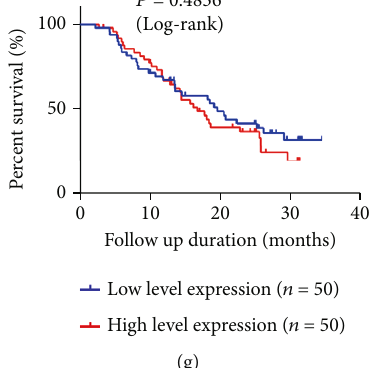
Figure 1: SIX1 expression in PC. (a, b) IHC scores for SIX1 expression in 100 pairs of PC tissues and adjacent tissues. (c) Representative IHC images of SIX1 expression in PC tissues and adjacent tissues. (d) According to IHC, SIX1 expression in PC tissues was signi fi cantly higher than that in the corresponding adjacent tissues. (e, f) Relative expression of SIX1 by qRT-PCR and western blotting in PC and HPNE cell lines; β -actin served as the internal control. (g) Kaplan – Meier curves showed no statistically signi fi cant e ff ect of SIX1 expression on OS. The data are presented as the mean ± SD from three independent experiments. ∗ P ≤ 0 : 05 , ∗∗ P ≤ 0 : 01 , and ∗∗∗ P ≤ 0 : 001